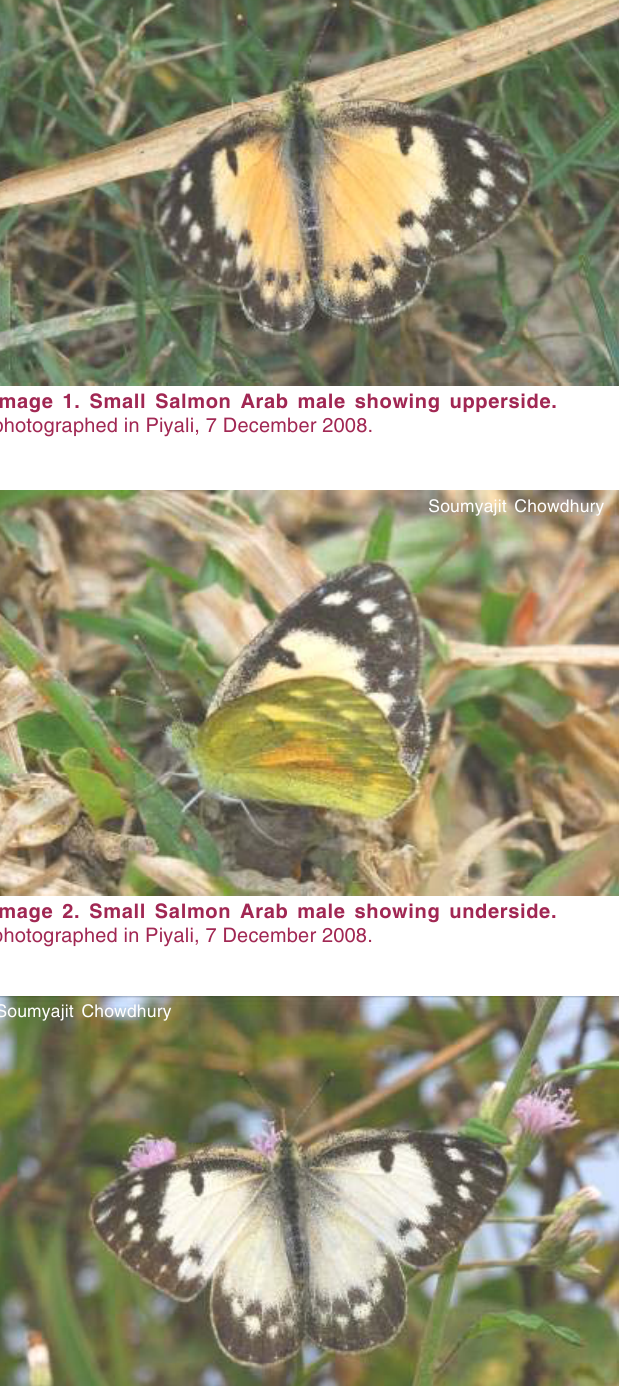
Soumyajit Chowdhury